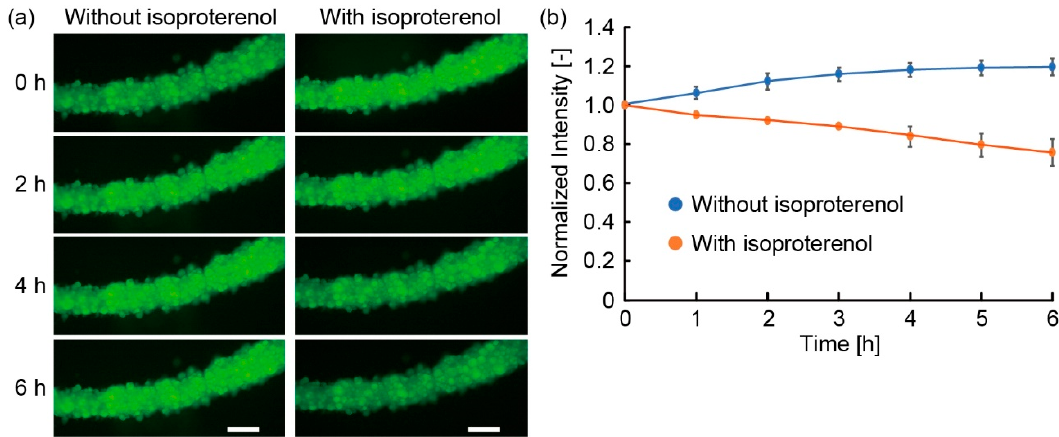
Figure 10. Changes in fluorescence intensity of lipid droplets stained with BODIPY when applying isoproterenol to the adipocyte microfiber on the anchoring device: ( a ) Time-lapse fluorescent images of the microfiber on the anchoring device; ( b ) Variation with time of fluorescence intensity of the adipocyte microfiber in specific observation area under repeating the experiment three times (mean ± s. d.). The fluorescent intensity is normalized with that at 0 h. Scale bars are 100 µm.